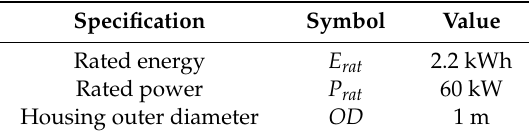
Table 1. OBOLAR-Fly SR drive prototype